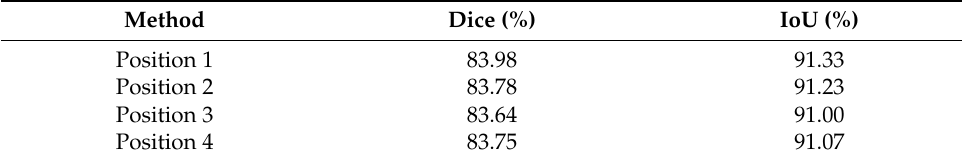
Table 4. Ablation experiments on the ISBI2016